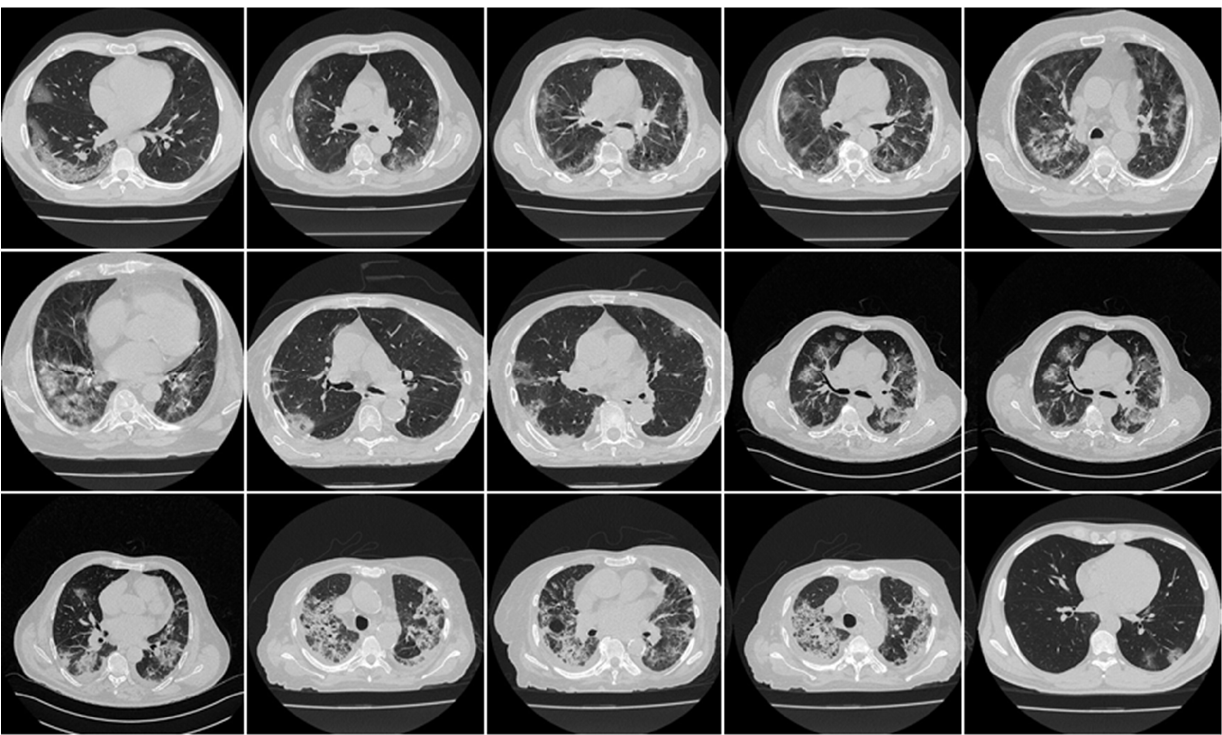
Figure 2. Raw CT images from the Croatia dataset.